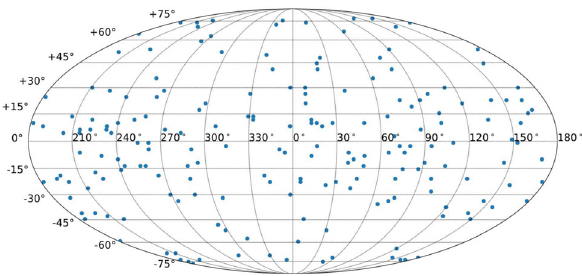
Fig. 5 The distributions of dipole directions derived from the 200 sim- ulations in the galactic coordinate system